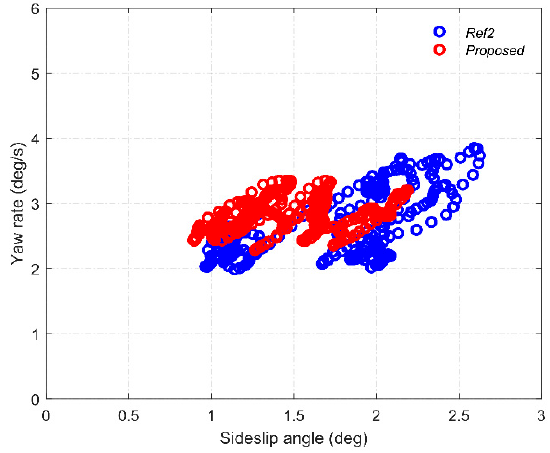
Figure 19. Comparison of phase planes. Table 2. Tracking error analysis.